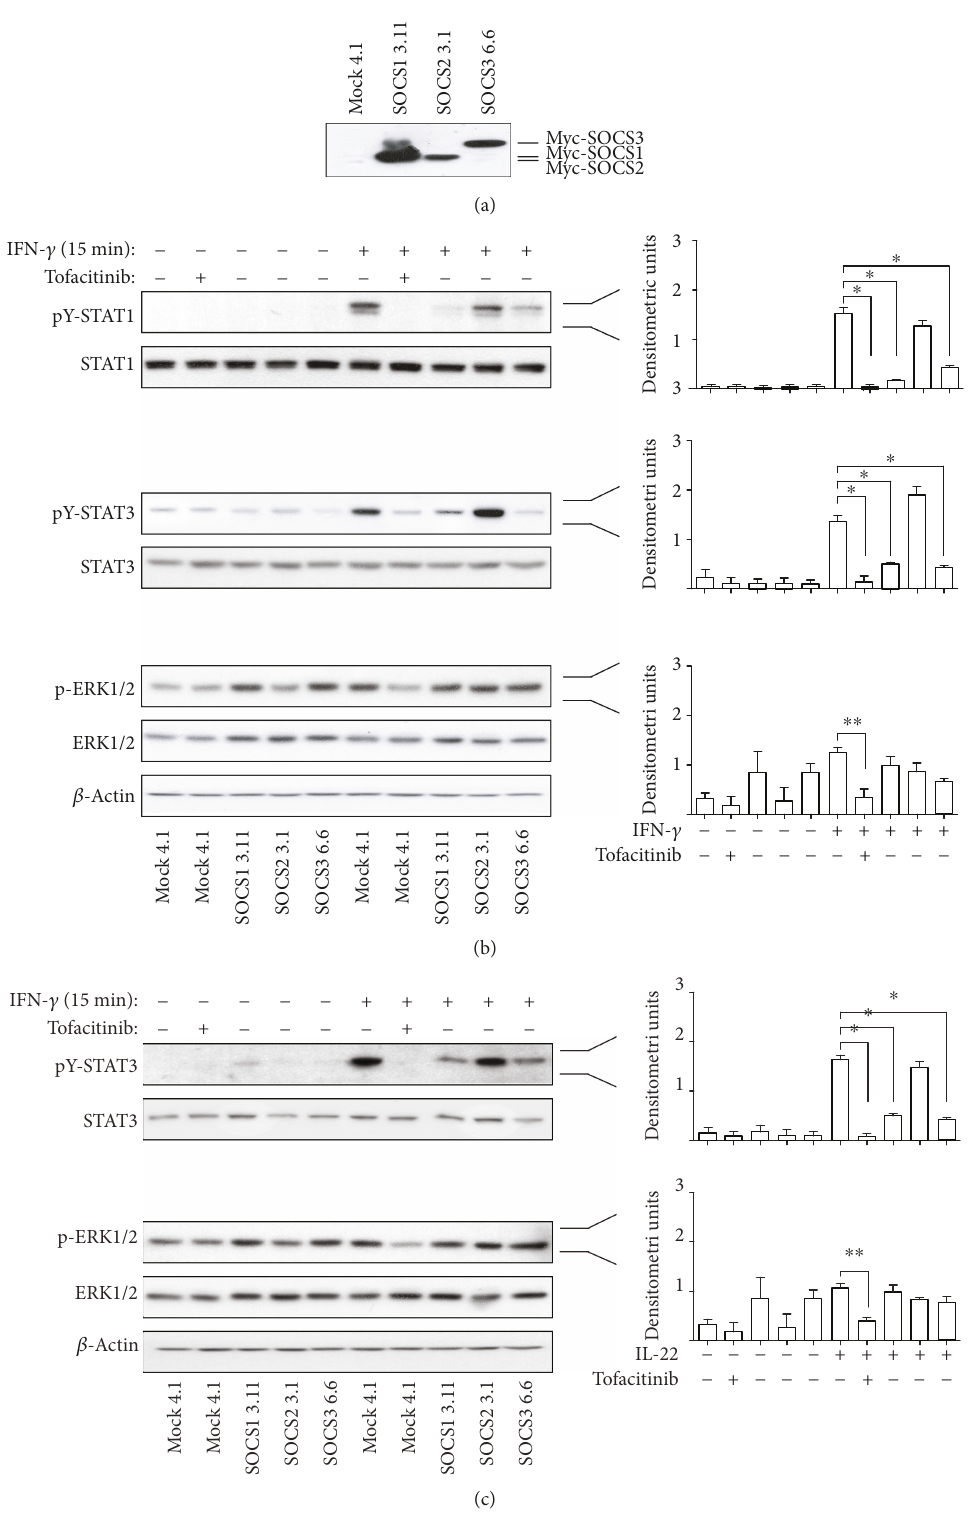
Figure 7: Tofacitinib inhibits the same IFN- γ - or IL-22-activated molecular pathways suppressed by SOCS1 or SOCS3. WB analysis was performed on protein lysates of HaCaT keratinocyte clones overexpressing SOCS1, SOCS2, or SOCS3, stimulated with IFN- γ (a) or IL-22 (b) or left untreated. Analysis was also performed on MOCK-transfected cells left untreated or treated with IFN- γ (a) or IL-22 (b), in the presence or absence of 5 μ M tofacitinib. Both basal and phospho-STAT1, phospho-STAT3, and phospho-ERK1/2 were evaluated. Graphs show densitometric analysis of WB bands, and data are expressed means of densitometric units, calculated using two and four di ff erent keratinocyte clones for each transgene and mock clones to detect STATs and ERK1/2 proteins, respectively. ∗ p < 0 01 , ∗∗ p < 0 05